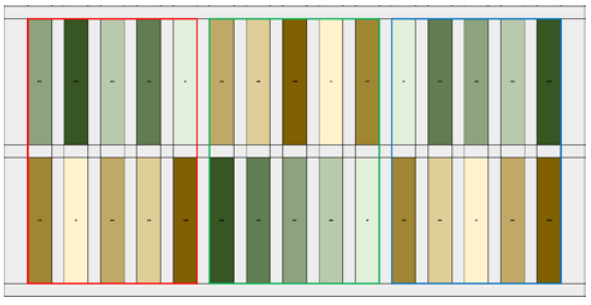
Figure 2 - Framework for data